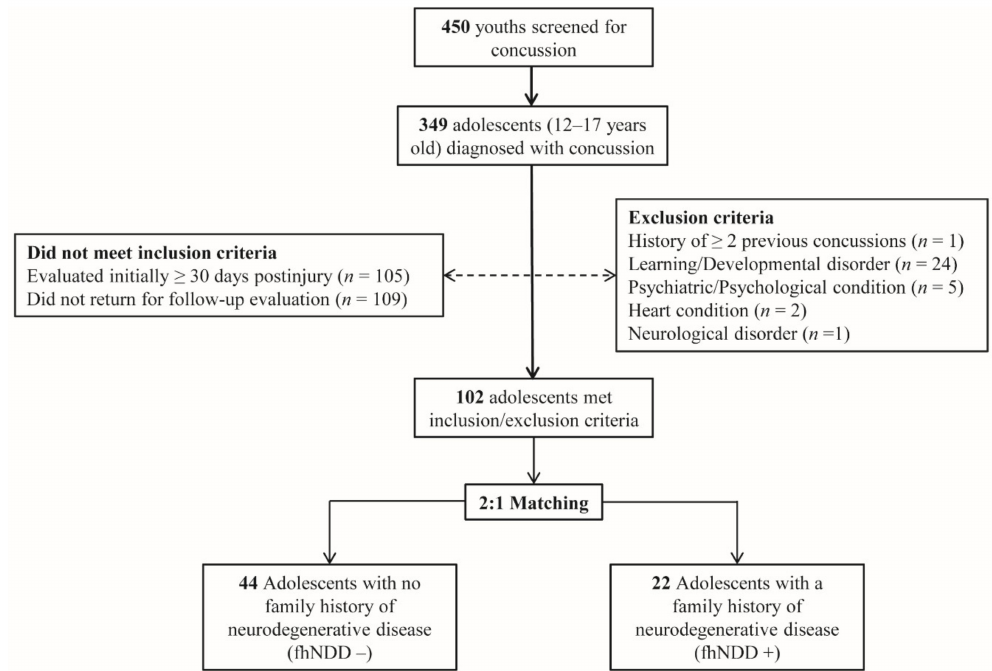
Figure 1. Flow diagram of sampled participants. Dotted line indicates excluded participants. Solid line indicates included participants.